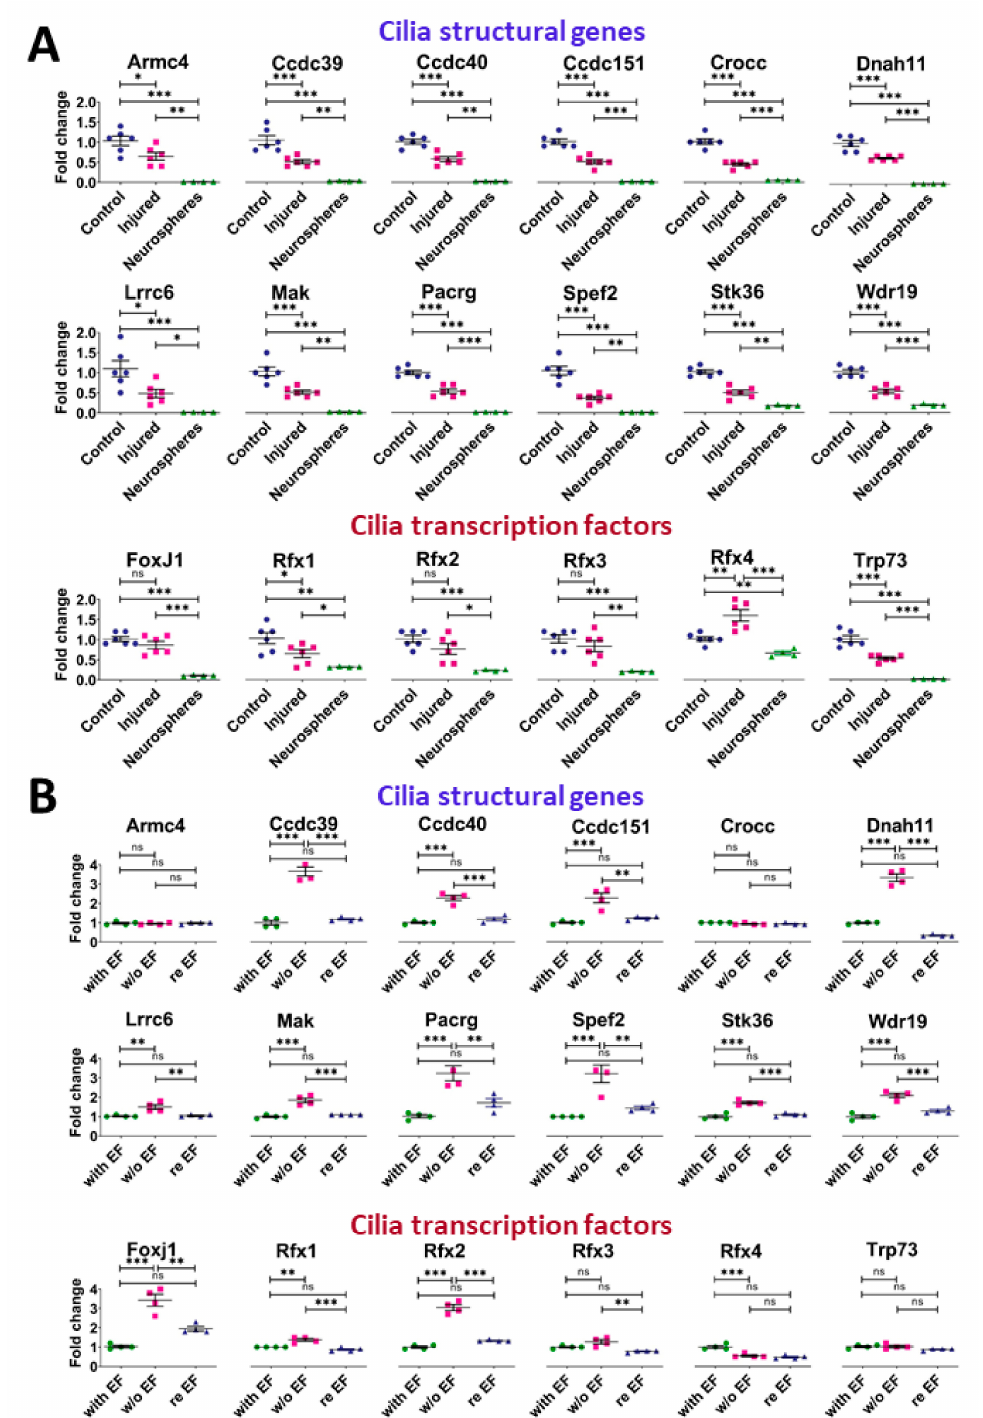
Figure 4. Cilia gene expression is affected by SCI and culture conditions. ( A ): Microarray quantifications of indicated genes in control vs injured spinal cord ependyma and growing spinal cord neurospheres ( n = 6 for spinal cords and n = 4 for neurosphere cultures). Tests = one way ANOVA with Tukey post-hoc tests. Values represent fold changes compared to control spinal cords. ( B ): Microarray quantifications of indicated genes in neurospheres cultured in 3 conditions ( n = 4 for each conditions): with EF (i.e., growing with EGF and FGF2), w/o EF (i.e., differentiated by removing EGF and FGF2), and re EF (reintroduction of EGF and FGF2 for 3 days after the differentiation step). Tests = one way ANOVA with Tukey post-hoc tests. Values represent fold change compared to neurospheres in the growing condition. ***, p < 0.001; **, p < 0.01; *, p ≤ 0.05. n.s. = not